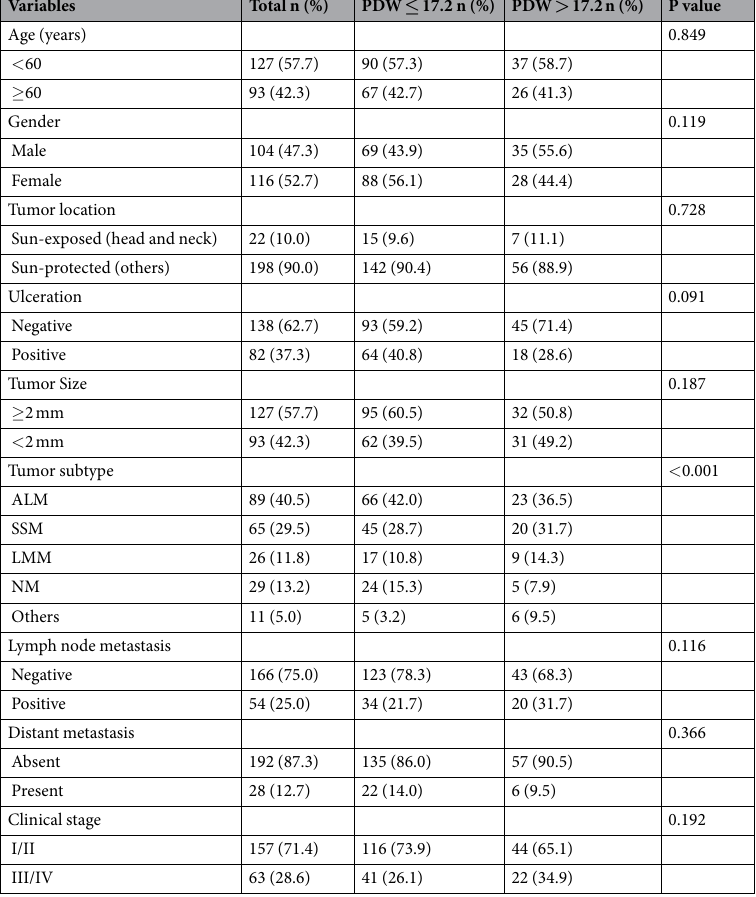
Table 1. Baseline characteristics of melanoma patients according to PDW levels. SSM, superficial spreading melanoma; LMM, lentigo maligna melanoma; ALM, acrolentigous melanoma; NM, nodular melanoma; PDW, platelet distribution width.